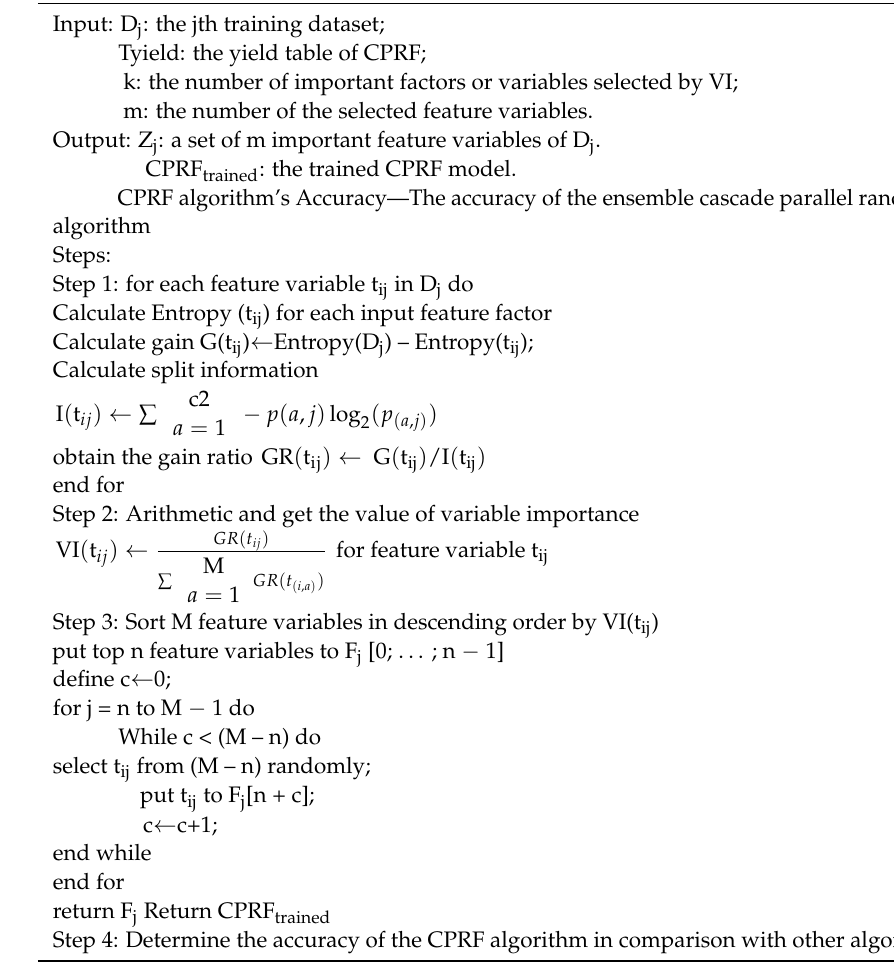
Algorithm 2: Using the CPRF algorithm to train the agricultural data in a cascading way